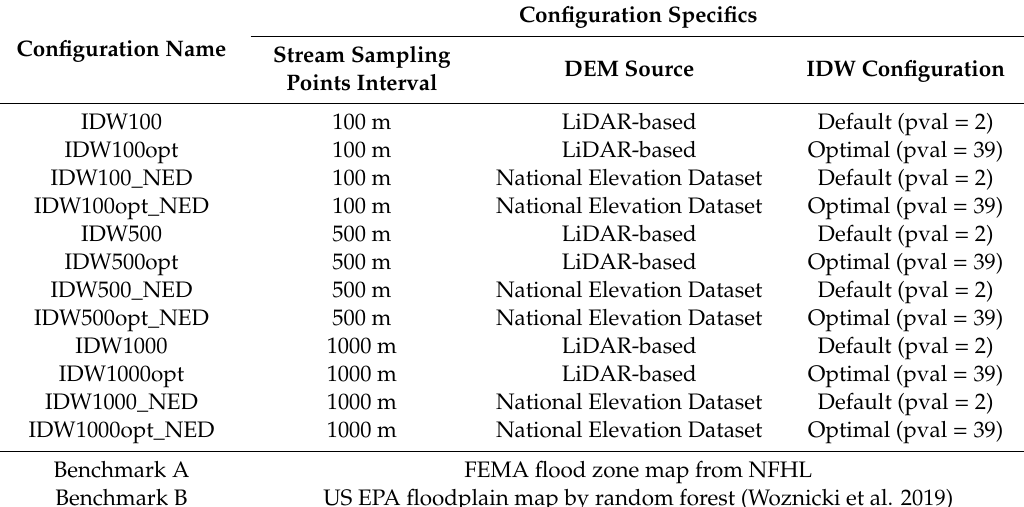
Table 1. Summary of model configurations and specification details for delineating